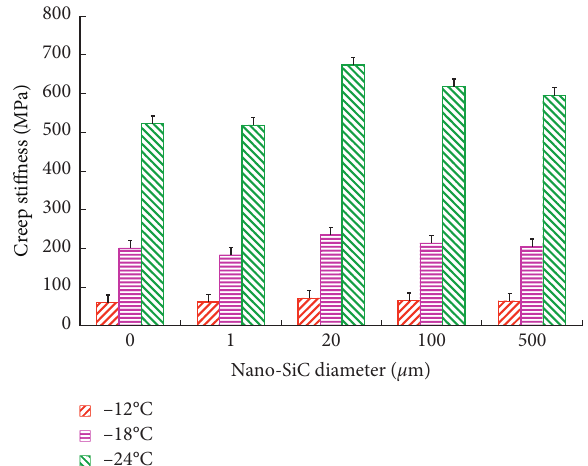
Figure 14: Creep stiffness of different nano-SiC particle